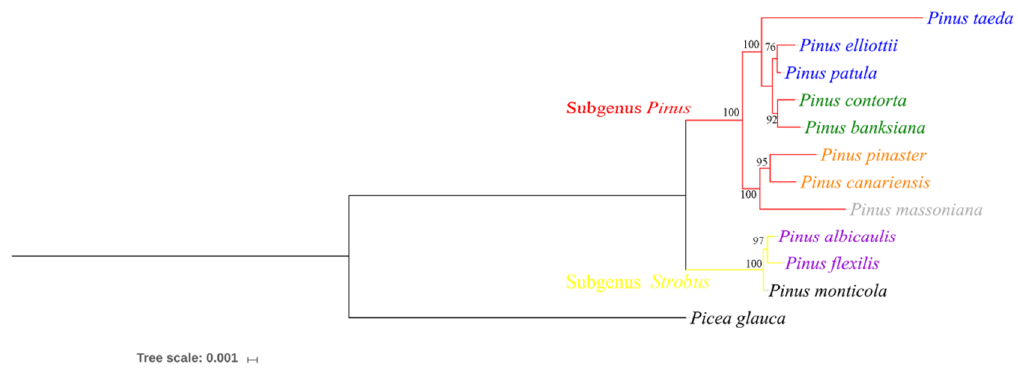
Figure 4. Phylogenetic analysis of the genus Pinus . The pines in the red and yellow branches are the subgenera Pinus and Strobus , respectively. The pines with their Latin names given in the same color in this picture are in the same subsection in their classification. The tree scale represents the proportional scale.